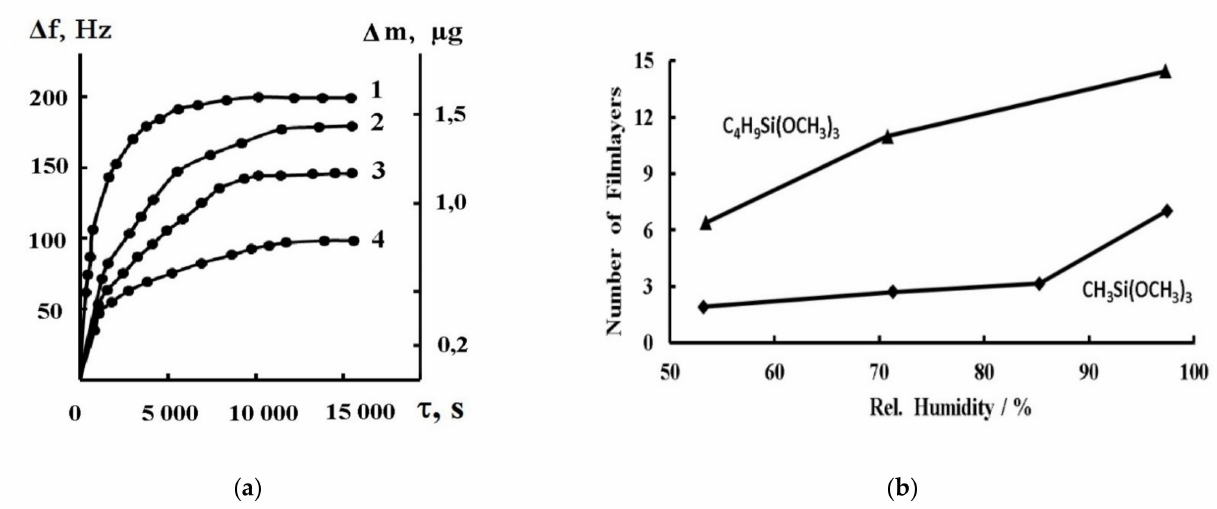
Figure 5. ( a )—Variation of the frequency of iron QCM and calculated mass gain as a function of irreversible adsorp- tion of MTMS (2, 4) and BTMS (1, 3). The Ar humidity was 53.3% RH (3, 4) and 100% RH (1, 2) [20]. ( b )—the films thicknesses (monolayers) vs. relative humidity of Ar used at the deposition [19,20]. Published with permission from NAUKA/INTERPERIODIKA